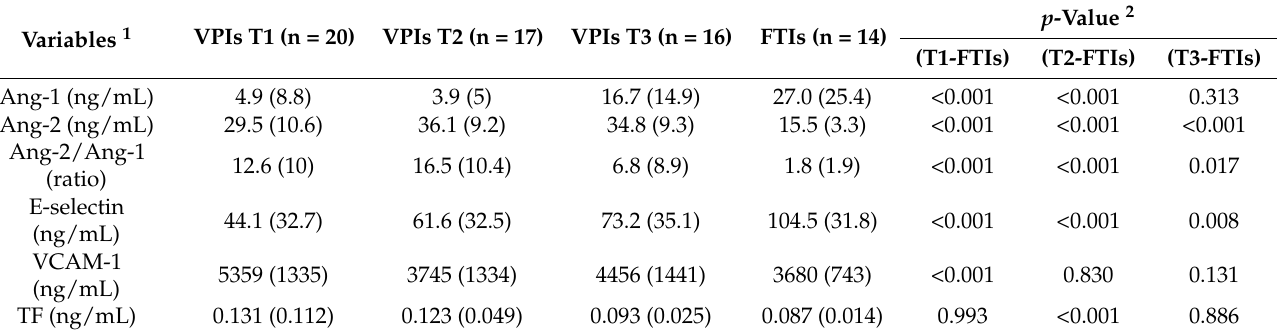
Table 2. Soluble endothelial markers